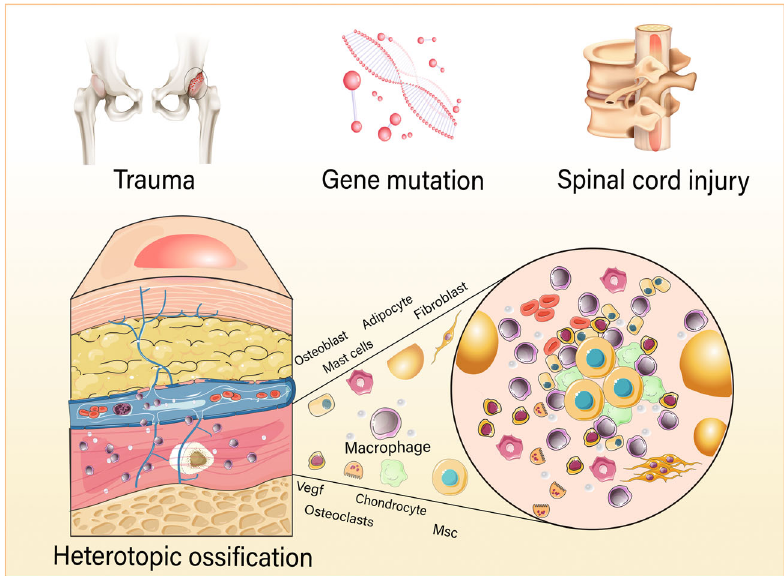
Fig. 1 Schematic illustration of heterotopic ossi fi cation (HO) formation. HO is the formation of extraskeletal bone in soft tissues, which is caused by neurogenic trauma (spinal cord injury, encephalitis, etc. ), gene mutation, and severe skeletal muscle trauma. HO is characterized as a multifactorial pathology and in fl ammatory disease. In fl ammation is a common feature of acquired and genetic HO, which manifests as pain, warmth, redness, and swelling. Macrophages, mast cells, MSCs, chondrocytes, bone cells, fi broblasts, osteoclasts, and osteoblasts exist in lesion areas of vessels and muscles. Macrophages in the in fl ammatory environment in fl uence osteogenic differentiation of MSCs and angiogenesis, the key steps of HO